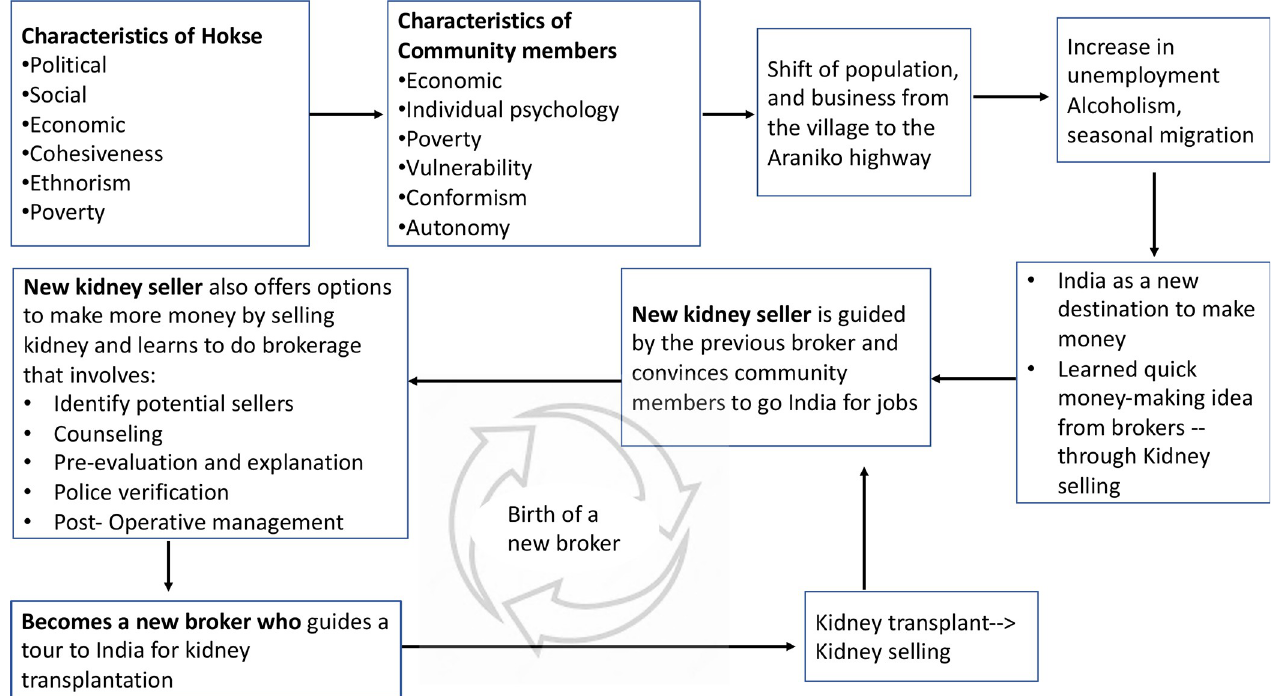
Fig 3. This figure outlines how Hokse village became the kidney hub. Along with the characteristics of village and community members, it shows a process of development of kidney brokers. Poverty and unemployment are exploited by a broker at first to offer them jobs in India. Further options for making more money including persuasion to sell kidneys are then implanted to the community member. As a result, the community member sells a kidney and returns to the village while remaining guided by the broker. In the pursuit of making easy money, the new kidney seller takes up a new role as a (new) broker and persuades community members to go to India for jobs and kidney